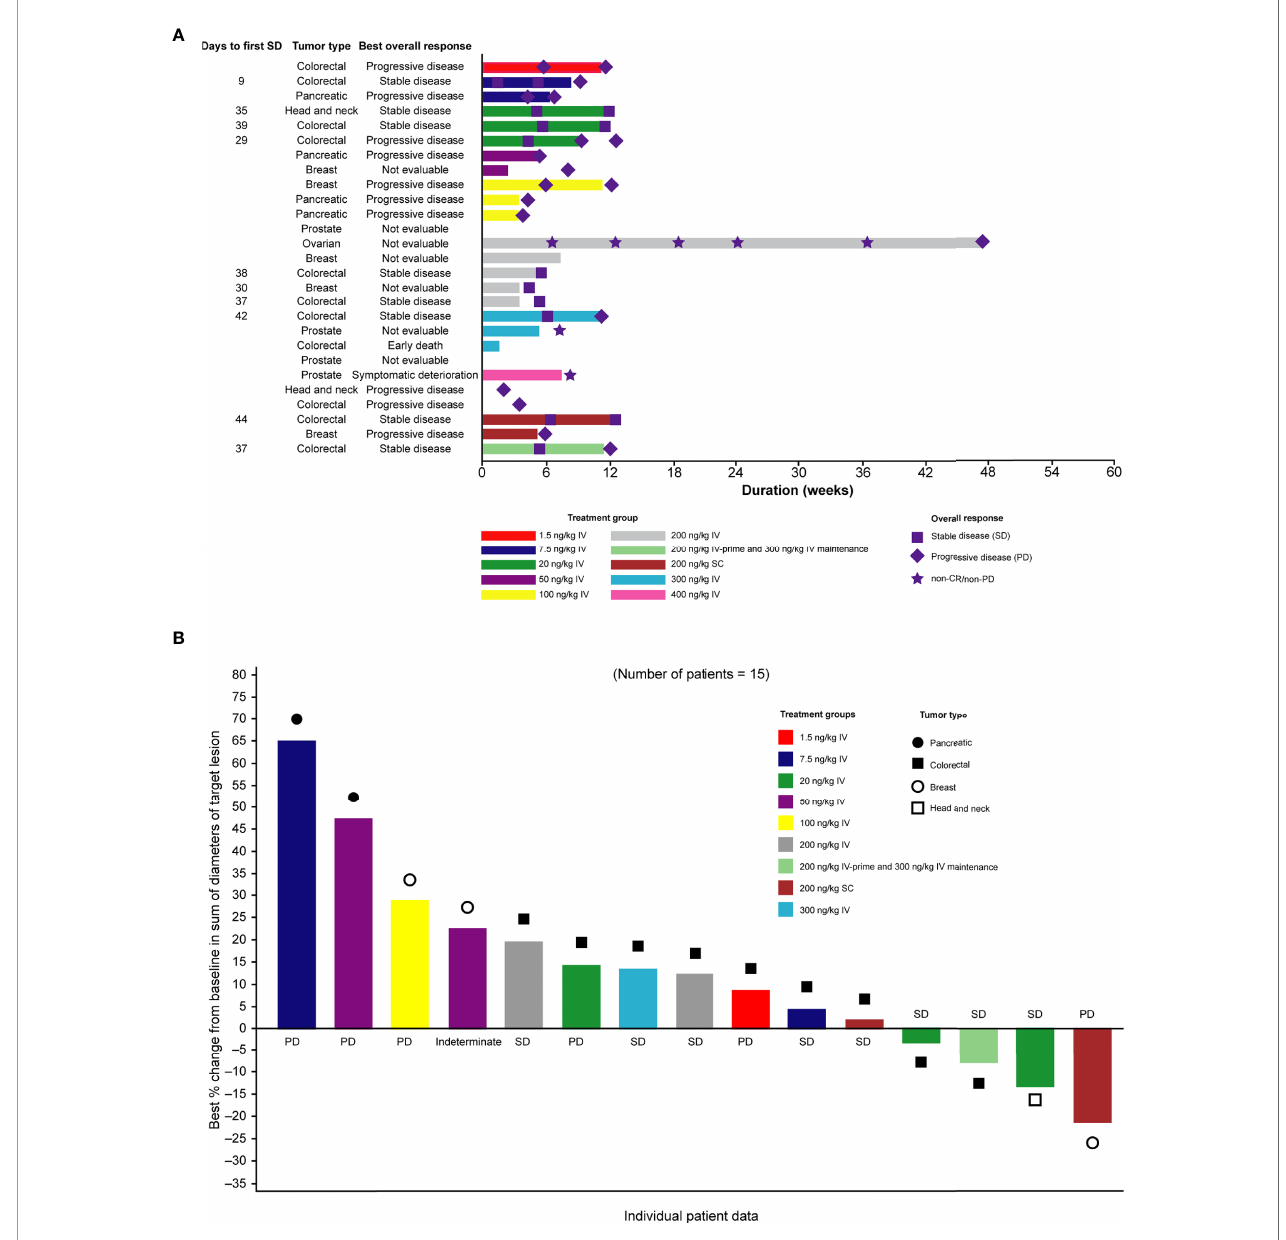
FIGURE 3 | (A) Swimmer plot of duration of treatment, according to dose group and (B) waterfall plot of best percentage change in tumor size from baseline. Only patients who were assessed at day ≥ 35 after fi rst dose are shown. CR, complete response; IV, intravenous; PD, progressive disease; SC, subcutaneous; SD, stable